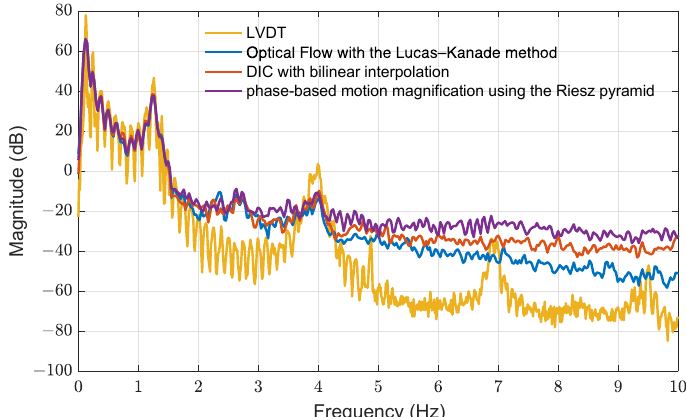
Figure 9. Power spectral density of roof displacement using the three motion extraction approaches and LVDT measurement.